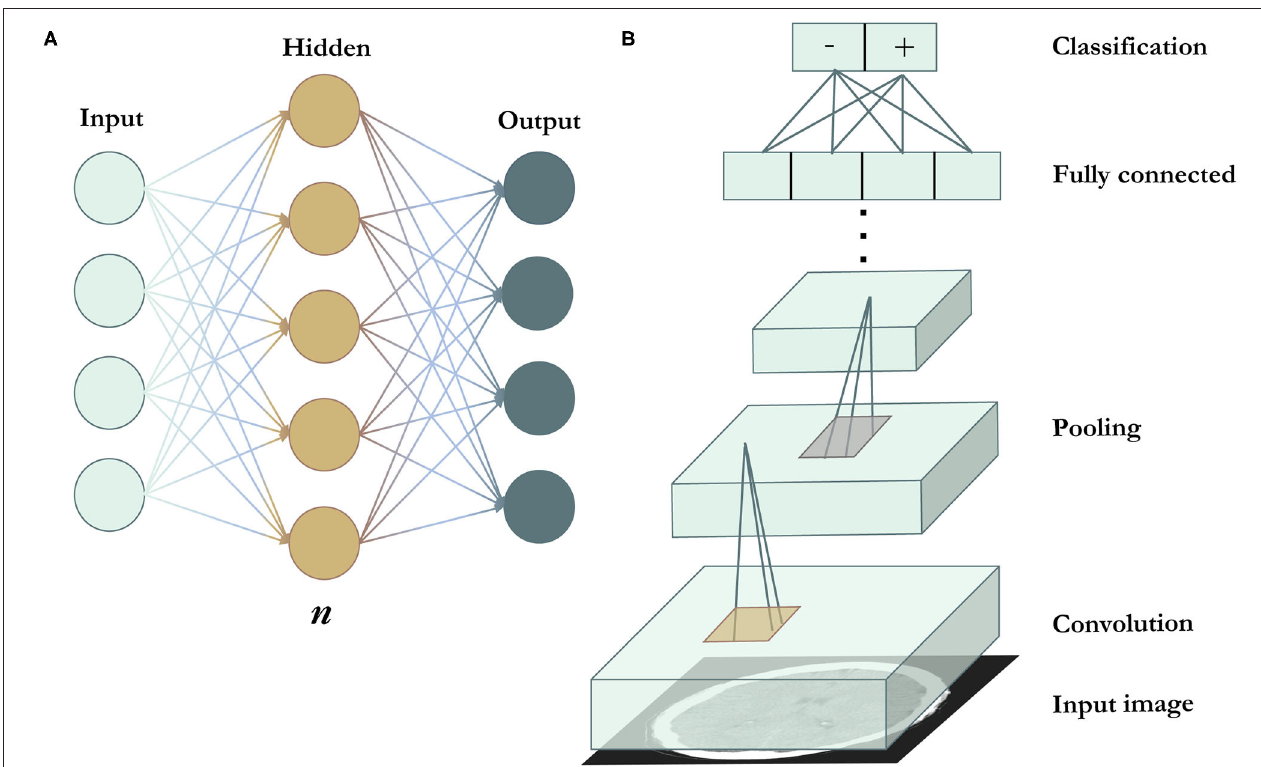
FIGURE 3 | Deep learning algorithms. (A) Is a schematic representation of an artificial neural network. n indicates the number of hidden layers. A network with n = 1, as seen in the figure, is the most basic and shallow form of a neural network. n can be increased to deepen the network and broaden its representation capacity. Increasing n results in the ability of the network to model tasks of increasing complexity, but also requires more training data to avoid overfitting (in which the model merely exploits the extra variables to achieve high performance on a specific training dataset, but fails to perform similarly on data outside of the training dataset). (B) Illustrates a convolutional neural network. Convolutional filters (in gold) are applied across the image to extract features, followed by pooling filters (in silver) that reduce feature map dimensionality. Most CNNs use multiple convolutional and pooling layers. The end layers include the fully connected and output